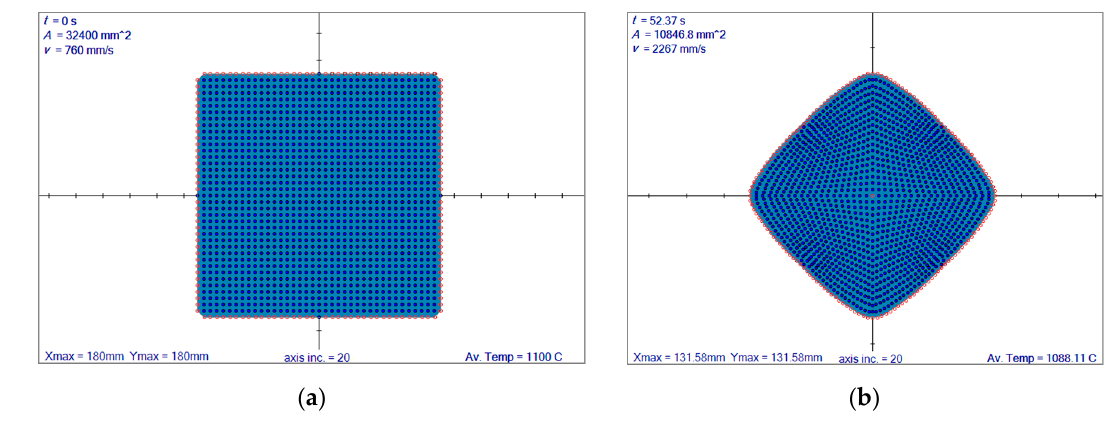
Figure 5. ( a ) Regular vs. ( b ) ENG node distribution.